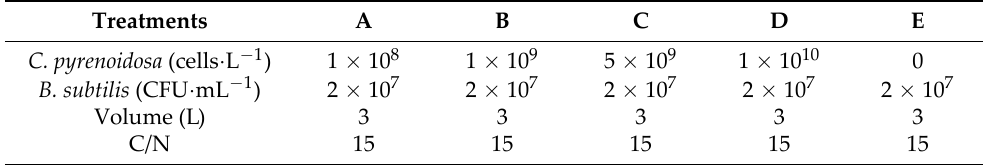
Table 1. C. pyrenoidosa initial inoculation concentrations of the treatments in experiment. Treatments A B C D E − 1 C. pyrenoidosa (cells · L ) 1 × 10